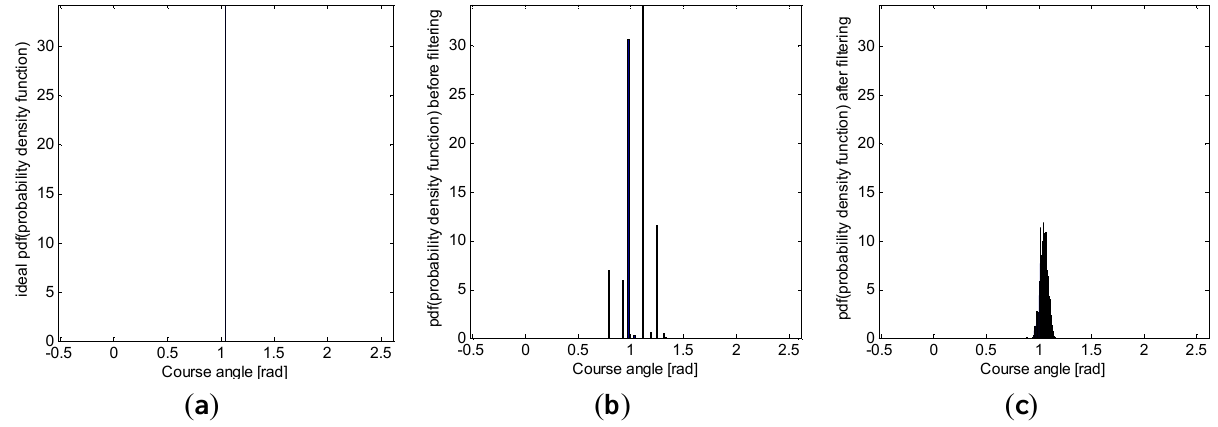
Figure 12. Heading angle ( θ ) histogram, ( a ) of the real ideal path; ( b ) of the grid-quantized path; and ( c ) of the recovered path after applying the proposed Kalman filter. Simulated data were obtained for a straight path with a 60° heading angle and at varying speeds of between 5 and 10 km/h. The histogram has been normalized to have a unitary area, representing an approximation to the probability density function ( pdf ) of the heading angle statistical random variable.